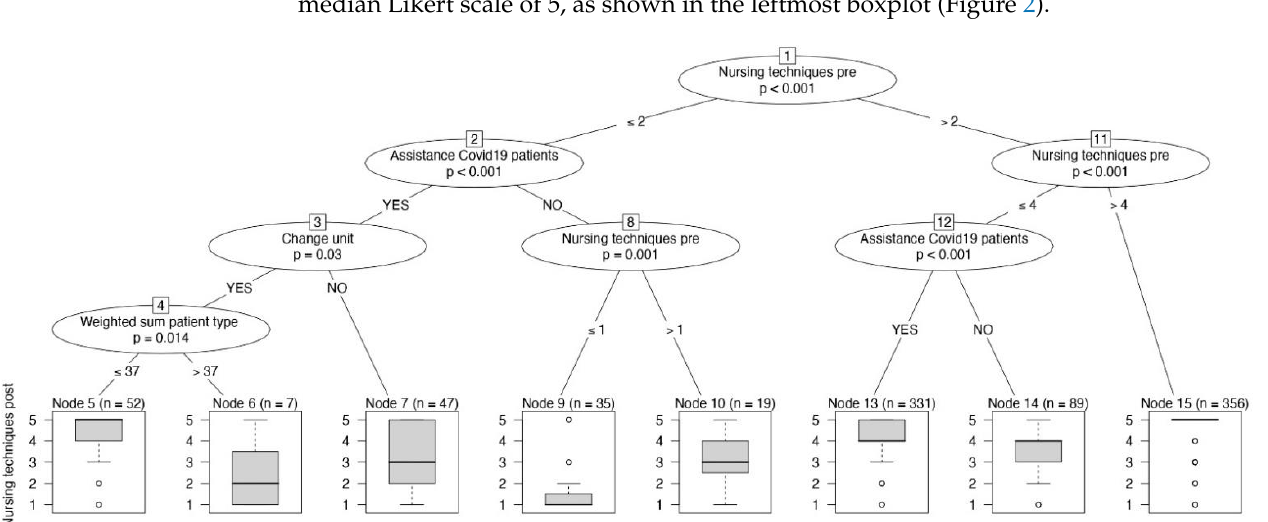
Figure 3. The conditional inference tree with the frequency of patient education as dependent variable, reported at the bottom of the figure as boxplot. In Figure 4, the decision tree with symptom management as the outcome variable is reported. The frequency of symptom management during the COVID-19 pandemic was similar to that before the pandemic ( p < 0.001; before: median 4, IQR 3–5; during: median 4, IQR 3–5), but it increased for RNs who cared for COVID-19 patients ( p < 0.001), as shown in the leftmost branch. Caring for a higher number of non-COVID-19 patients (>6) in- creased the frequency of symptom management ( p = 0.037), as reported in the eighth node, with a median Likert scale of 4. Nurse–patient relationships before the pandemic were associated with those during the pandemic ( p < 0.001; before: median 5, IQR 4–5; during: median 4, IQR 2–5), but nurses working in high-intensity COVID-19 units who reported frequent nurse–patient relation- ships before the pandemic had no chance to relate with patients during the pandemic ( p = 0.002), as shown in the rightmost branch of the conditional decision tree reported in Figure 5.